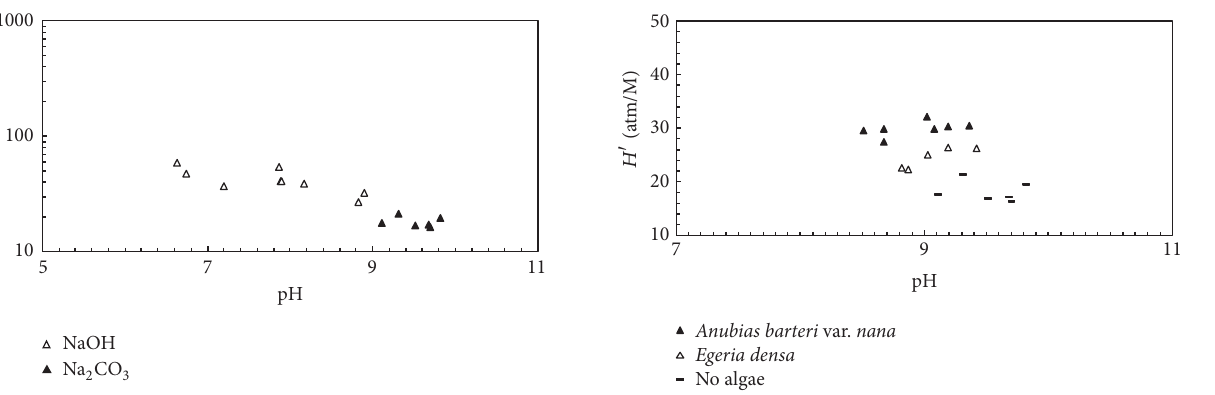
Figure 5: Variations of apparent Henry’s Law constants with pH (at 27 ∘ C) for seeding different algae